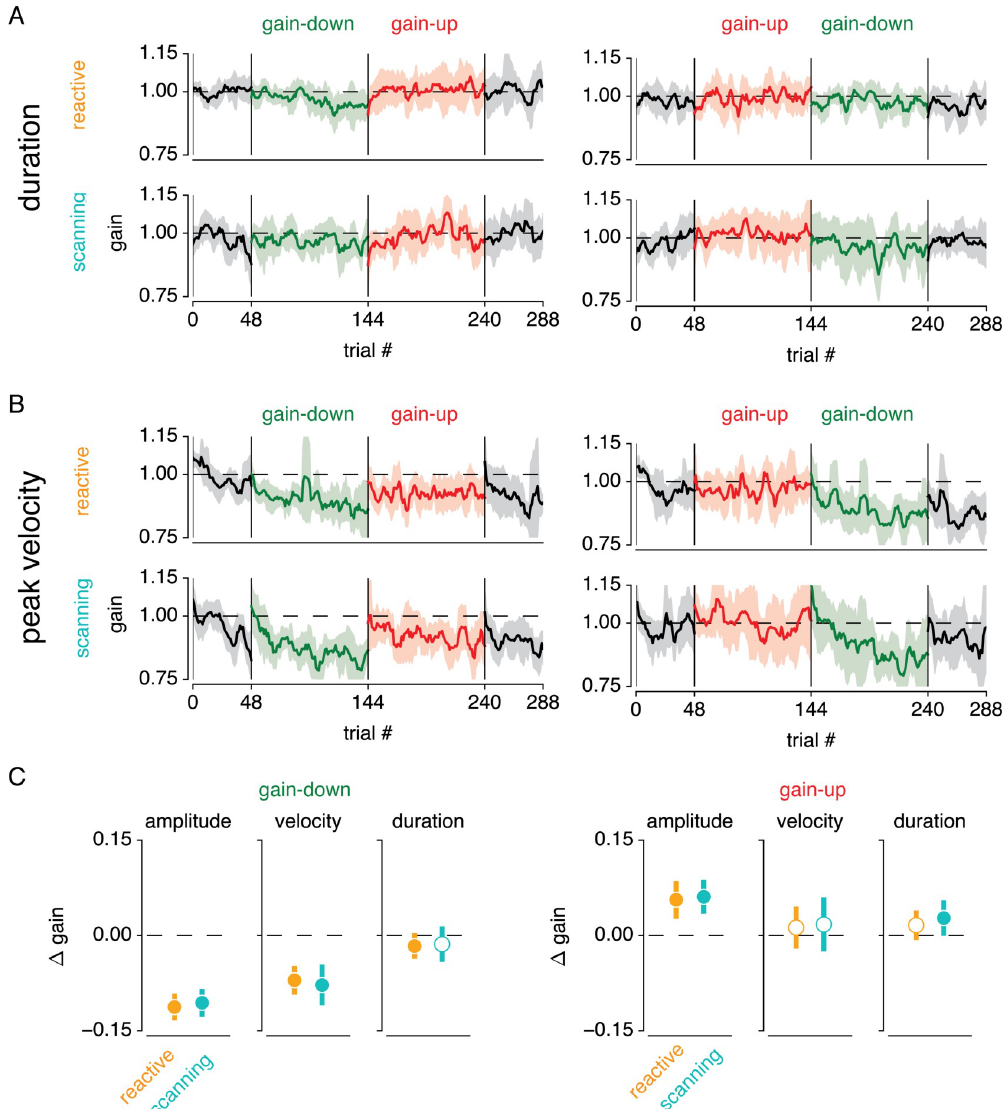
Fig 7. Saccade duration and peak velocity changes. Saccade duration (A) and peak velocity (B) across trials in reactive and scanning saccade adaptation, for the two different gain direction block orders (down-up and up-down). Saccade duration and peak velocity are depicted as a ratio to the median across the first block (per saccade direction, see Methods) and shown as running average over 6 saccades (the hexagonal period). Shaded areas correspond to 95% CI over participants. (C) Median saccade amplitude, peak velocity and duration over the last 16 trials of the second bock (i.e. first adaptation block). Error bars indicate 95% CI over participants.